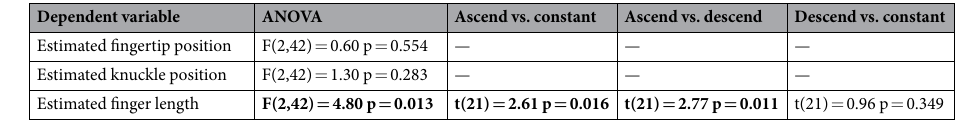
Table 1. Results from statistical tests on estimates of fingertip position, knuckle position and finger length in Experiment 1. Results from ANOVAs comparing the effects of sound in the three conditions are in the second column. Significant effects were further investigated with independent-samples t-tests (with correction for multiple comparisons α = 0.017) and are displayed in columns three to five. Significant differences are marked in bold